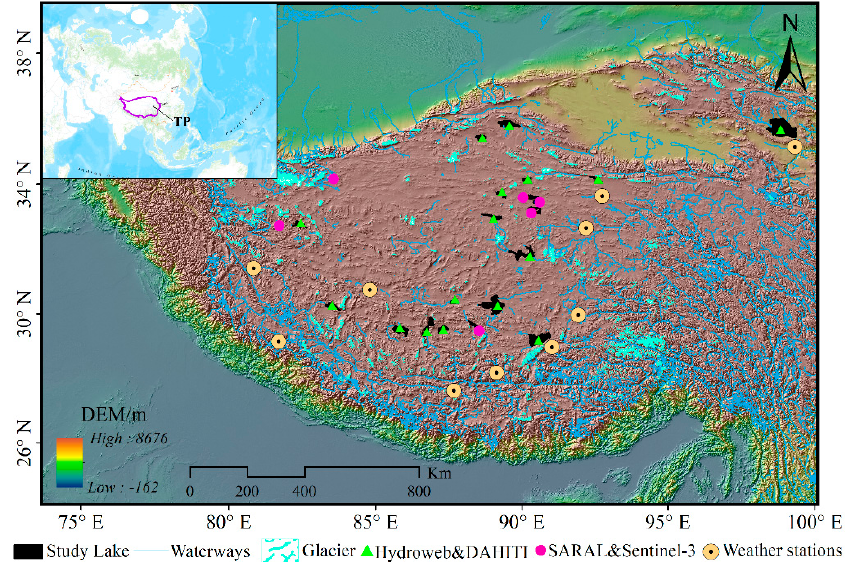
Figure 1. Locations and satellite altimetry overpass of the selected lakes over the Tibetan Plateau (TP) and nearby meteorological stations.